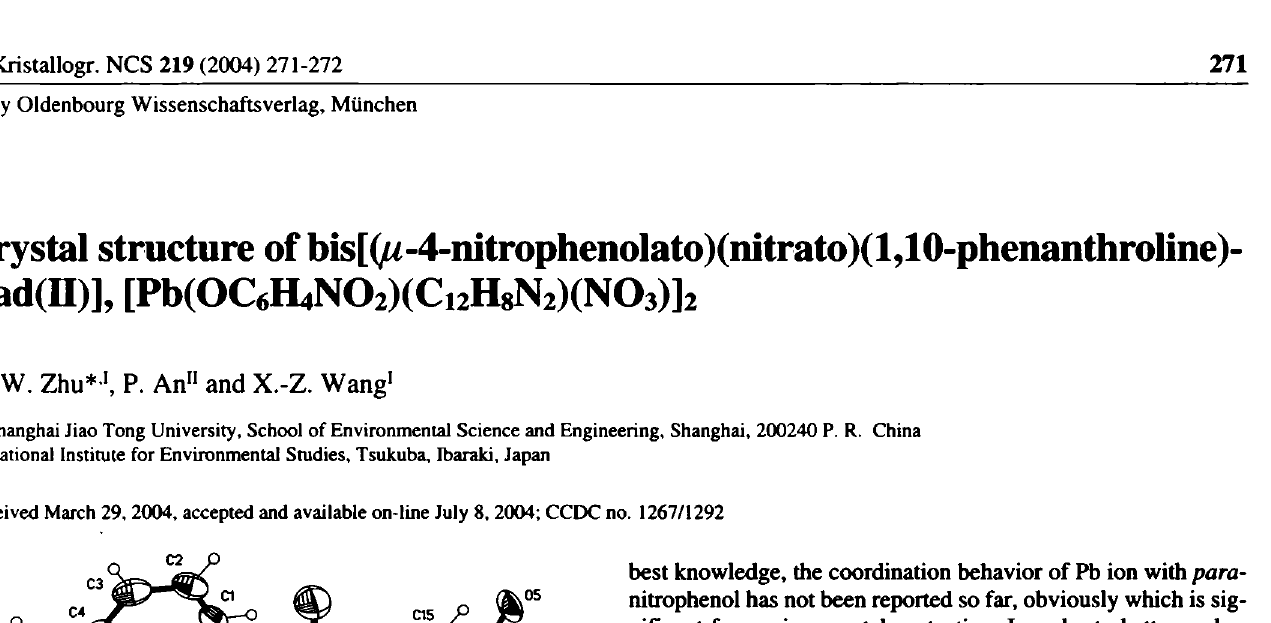
Table 1. Data collection and handling.